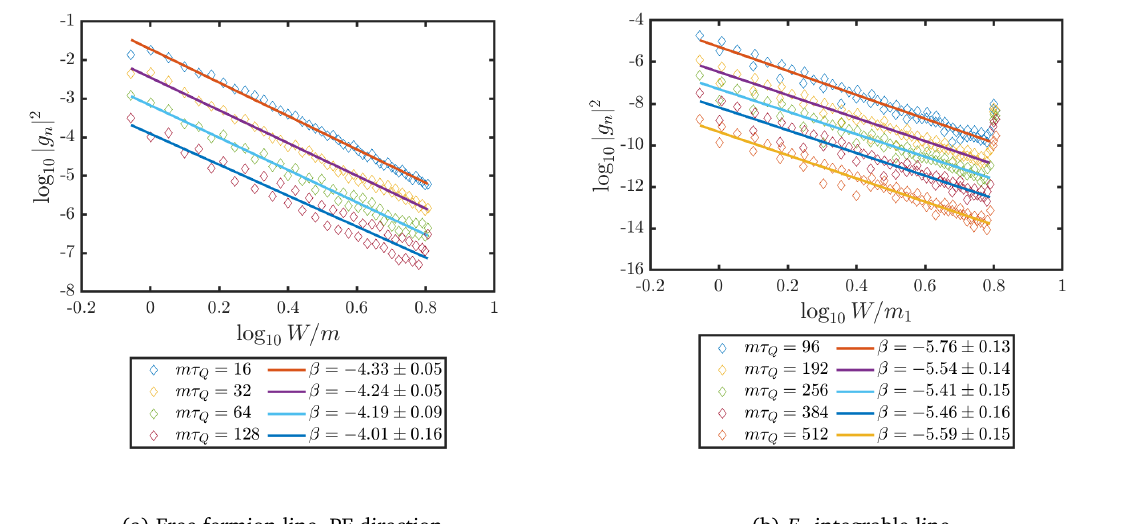
Figure 3.7: High-energy overlaps for ramp protocols ending at the critical point with = 51. Data from different ramp rates are shifted vertically for bet- mL = 50, N cut ter visibility. The slopes are linear fits of the logarithmic data and are close to the = − 4 and β = − 5.75. Outlying highest-energy exponents predicted by APT: β E 8 FF overlaps are omitted from the linear